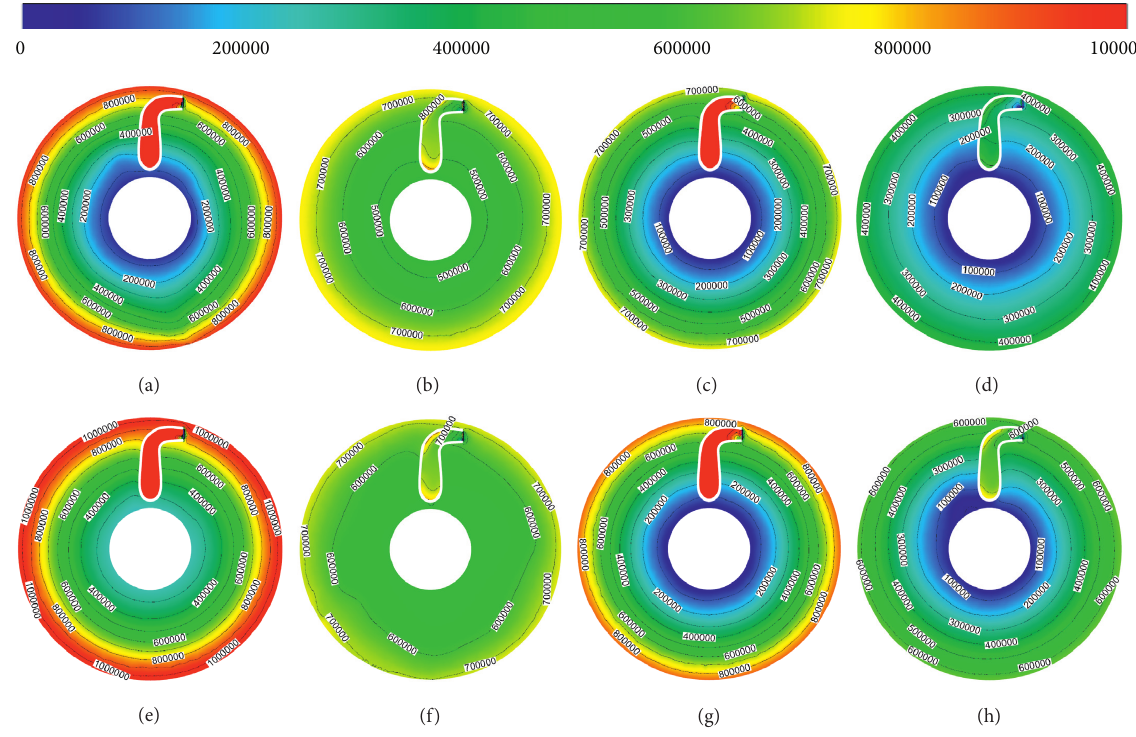
Figure 6: Pressure distribution at Z 1 characteristic section. (a) S 1 . (b) S 2 . (c) S 3 . (d) S 4 . (e) S 5 . (f) S 6 . (g) S 7 . (h) S 8